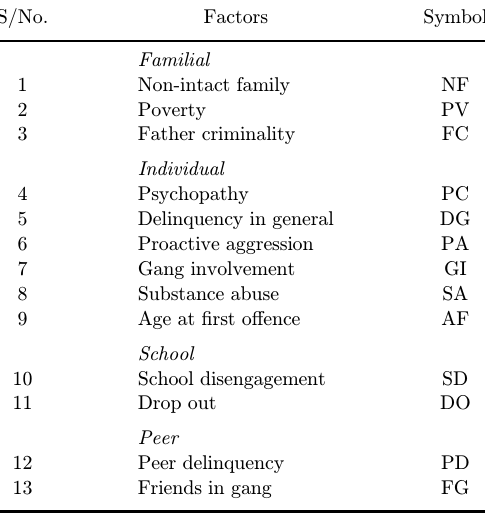
Table 1. Factors linked to youth violence (VI) in the psychology, social science, and criminology literature and their symbols, organized according to whether they are familial, individual, school, or peer.